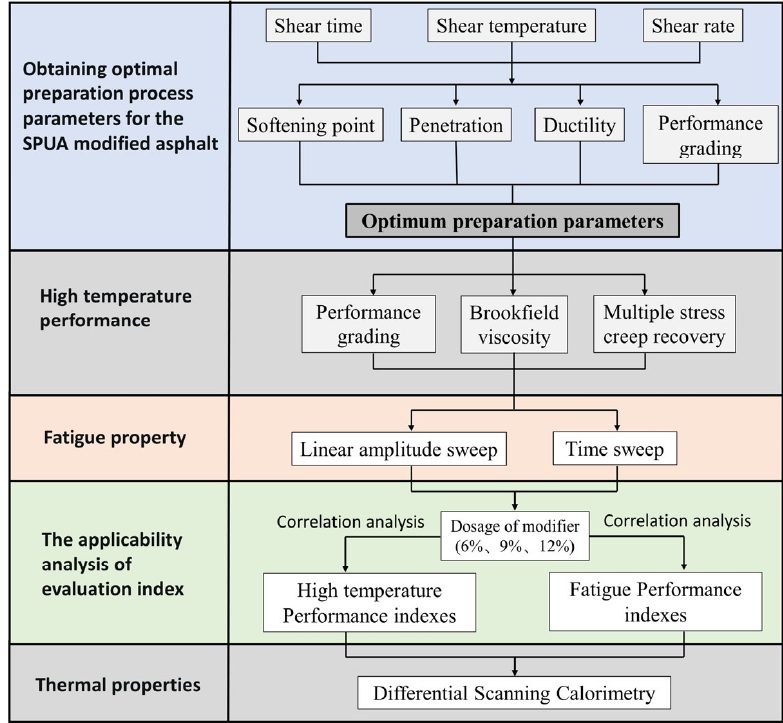
Figure 3. Research routes.